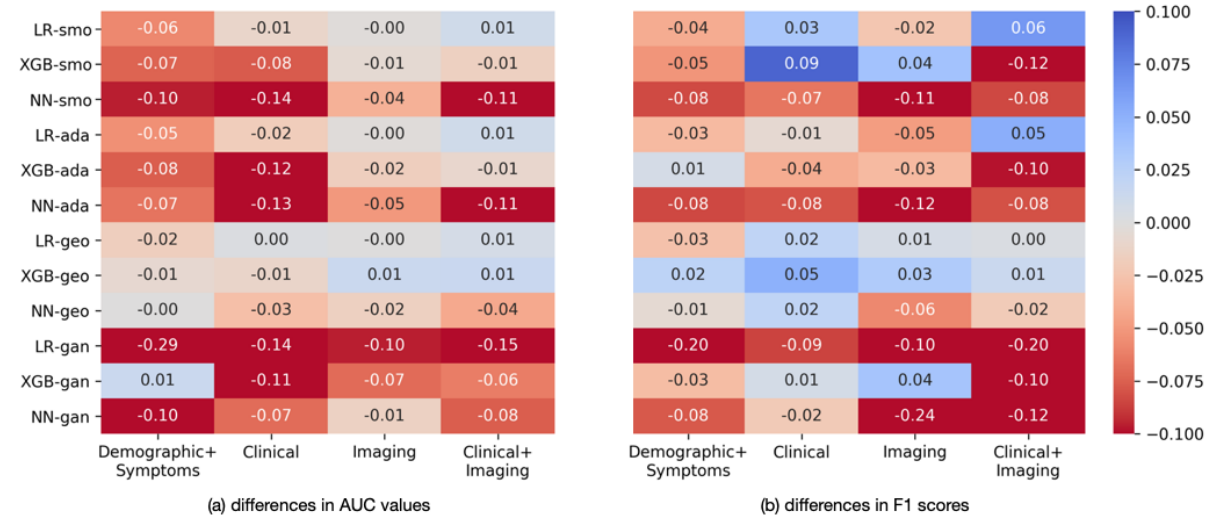
Figure 3. Differences in the (A) area under the curve values and (B) F1 scores with oversampling and without oversampling. Positive values (blue) indicate oversampling resulting in higher values, negative values (red) indicating oversampling resulting in lower values. smo: synthetic minority oversampling; ada: Adaptive Synthetic sampling; geo = geometric synthetic minority oversampling; gan: conditional generative adversarial network; LR: logistic regression; NN: neural network; XGB: XGBoost.